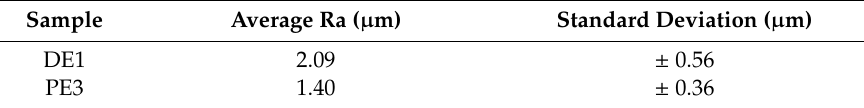
Table 2. Results of roughness in pieces cut with discs DE1 and PE3.